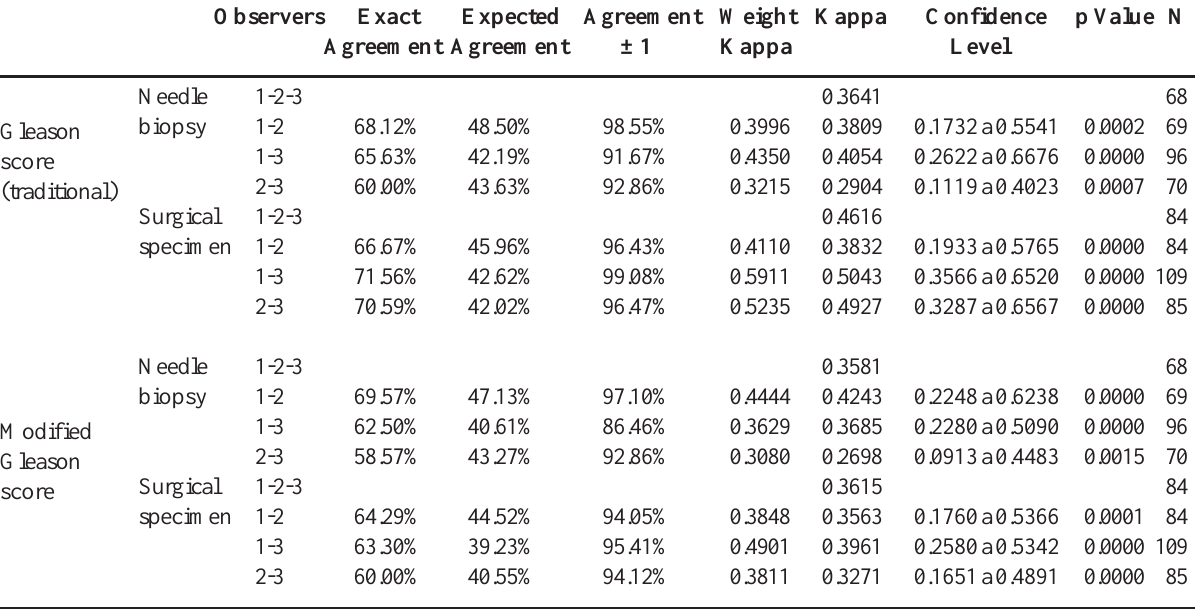
Table 3 – Interobserver agreement as regards Gleason score (traditional) and modified Gleason score in needle biopsies and surgical specimens, considering each patient as an independent